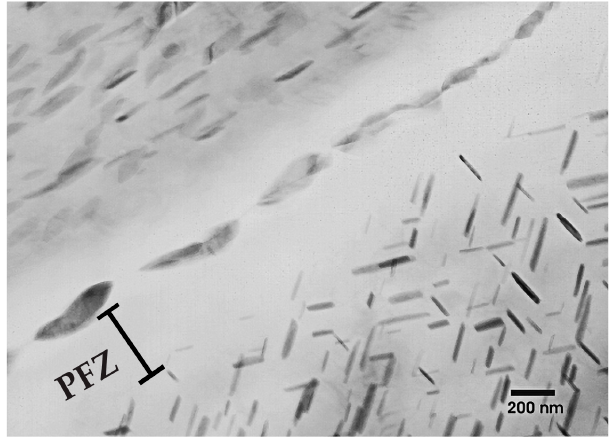
8 of 16 Figure 6. TEM images of alloy AZ61: ( a ) TEM micrograph of a Mg 17 Al 12 particle located on a triple point grain boundary with ( b ) corresponding [1 − 11] SAD pattern and ( c ) pattern including contri- butions from MgO (ring pattern) and Mg matrix (additional reflections). 3.1.3. TEM of Alloy WE43-T5 The WE43-T5 alloy contains plate-shaped precipitates, as shown in Figure 7. The pre- cipitates are found both in the interior of the grains as well as along the grain boundaries. Near the grain boundaries, there is a 300 nm wide precipitation free zone (PFZ), which indicates strong diffusion towards the grain boundaries. EDS analysis of the precipitates, depicted in Table 4, shows that they are enriched in Nd and Y as compared to the sur-